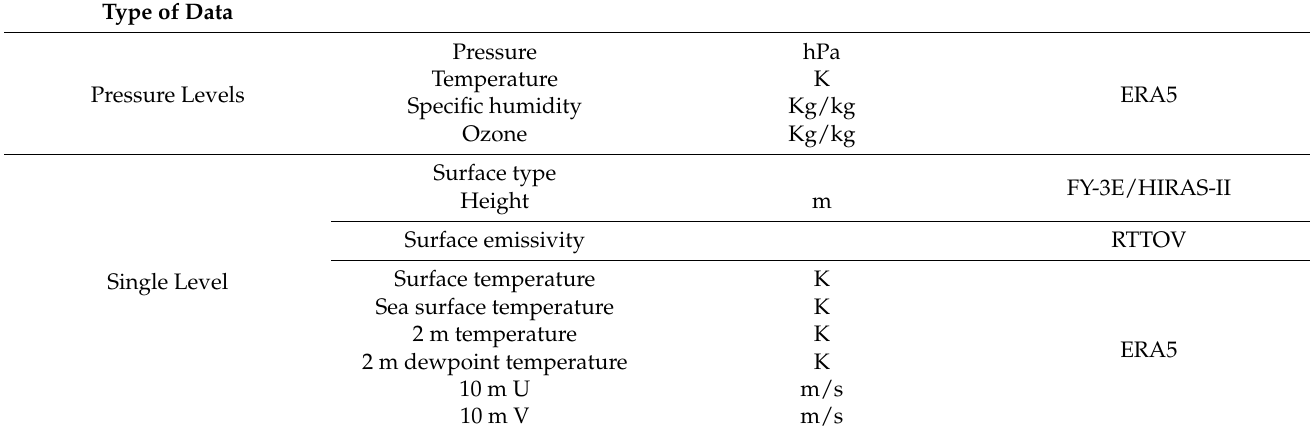
Table 3. Input parameters of